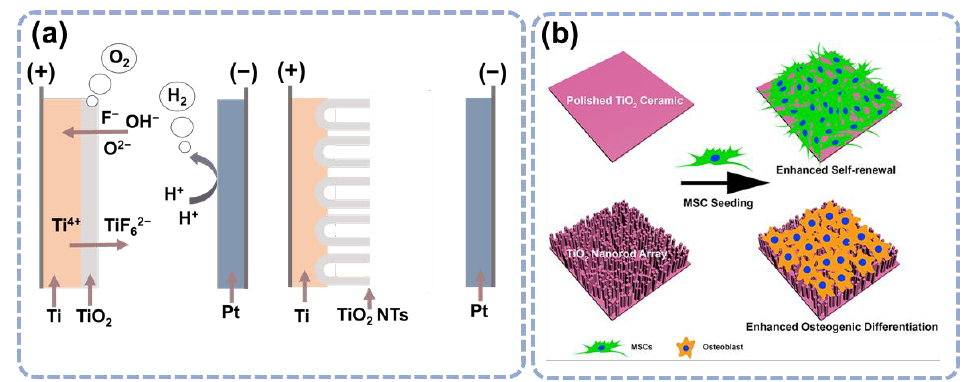
Figure 3. The topological nanostructures enhance osteogenic proliferation and differentiation. ( a ) The well-established fabrication process of TiO 2 nanotubes. ( b ) The enhanced differentiation of BMSC on the nanorods. Reprinted with permission from Ref [48]. John Wiley and Sons, 2016.